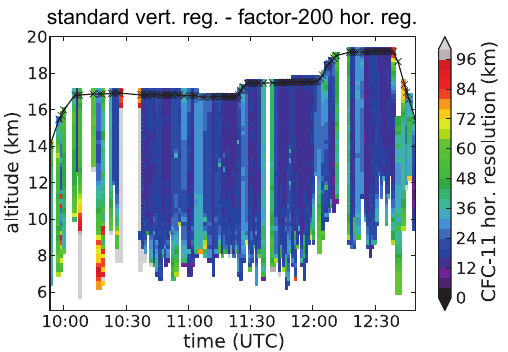
Fig. 9. A cross-section of CFC-11 horizontal resolution (FWHM) for the factor-200 horizontal regularisation strength.